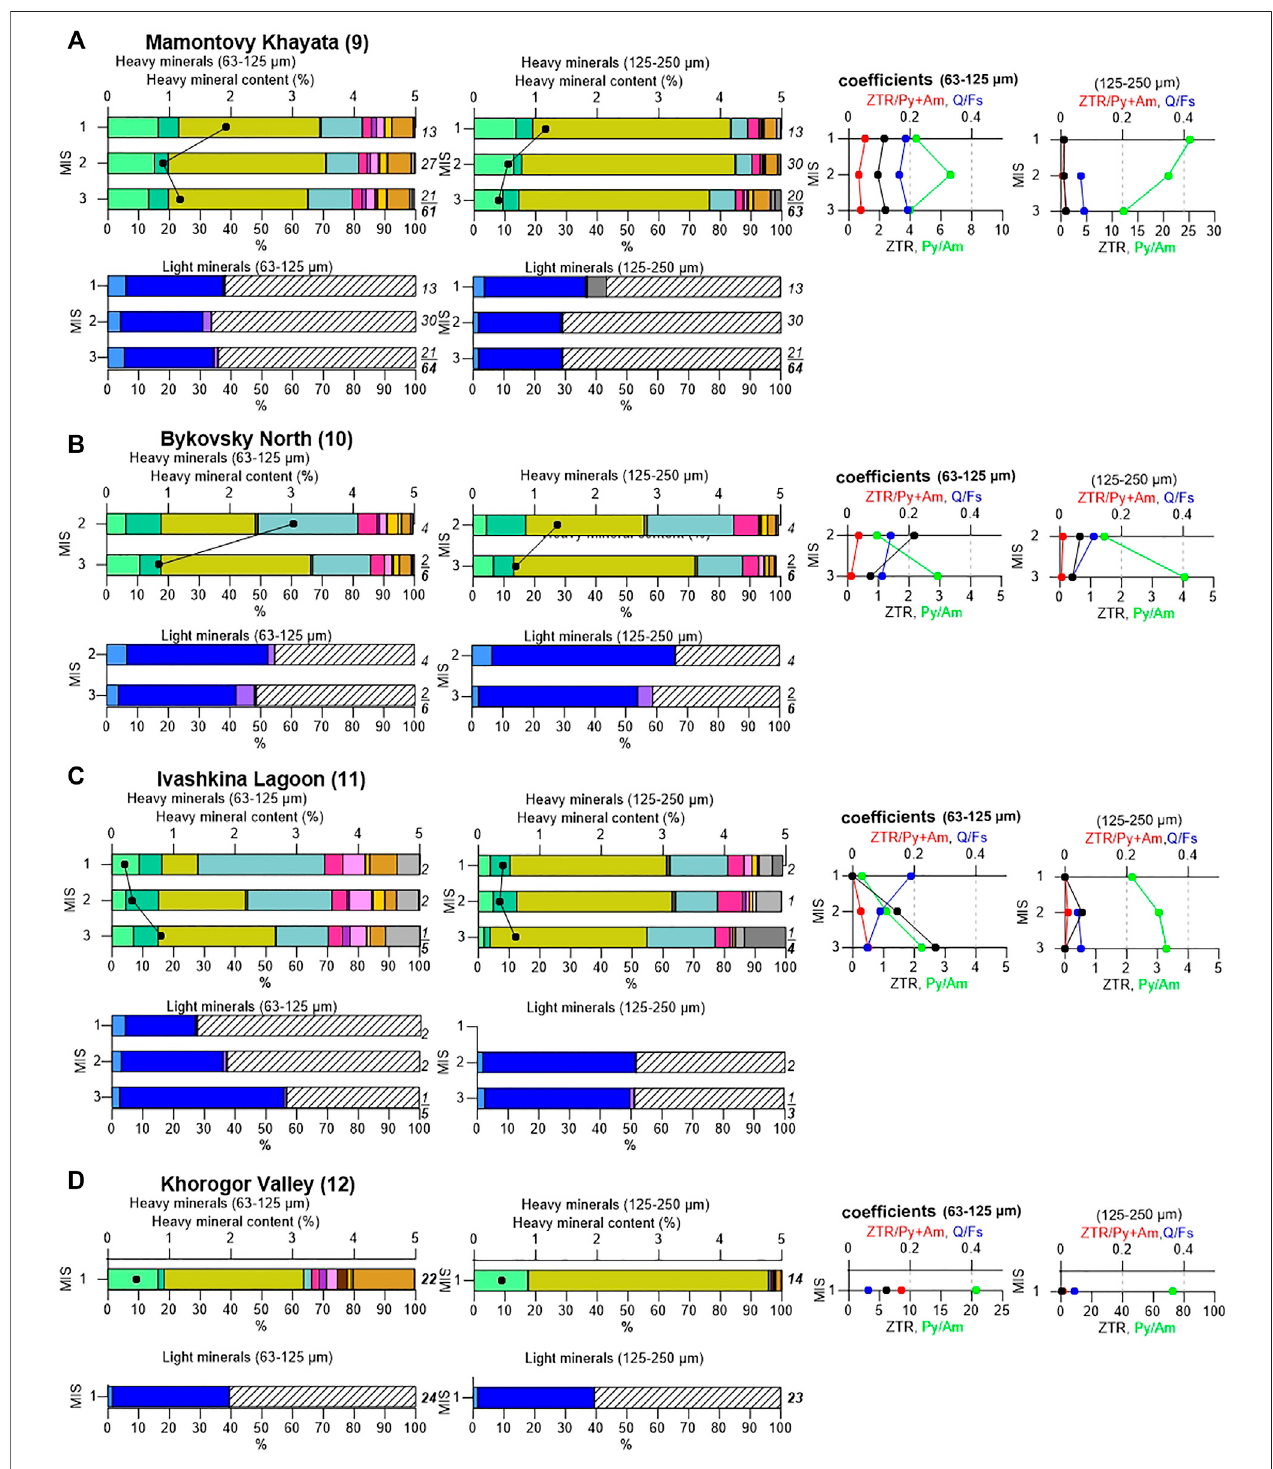
FIGURE 4 | Heavy and light mineral associations of the fi ne and coarse fractions, the heavy mineral contents, and the corresponding mineral coef fi cients from Bykovsky Peninsula at study sites (A) Mamontovy Khayata (9), (B) Bykovsky North (10), (C) Ivashkina Lagoon (11), and (D) the Khorogor Valley (12). The number of samples is in italics to the left of each diagram (Note the partly different scales for the mineral coef fi cients). For the legend, see Figure 2 .